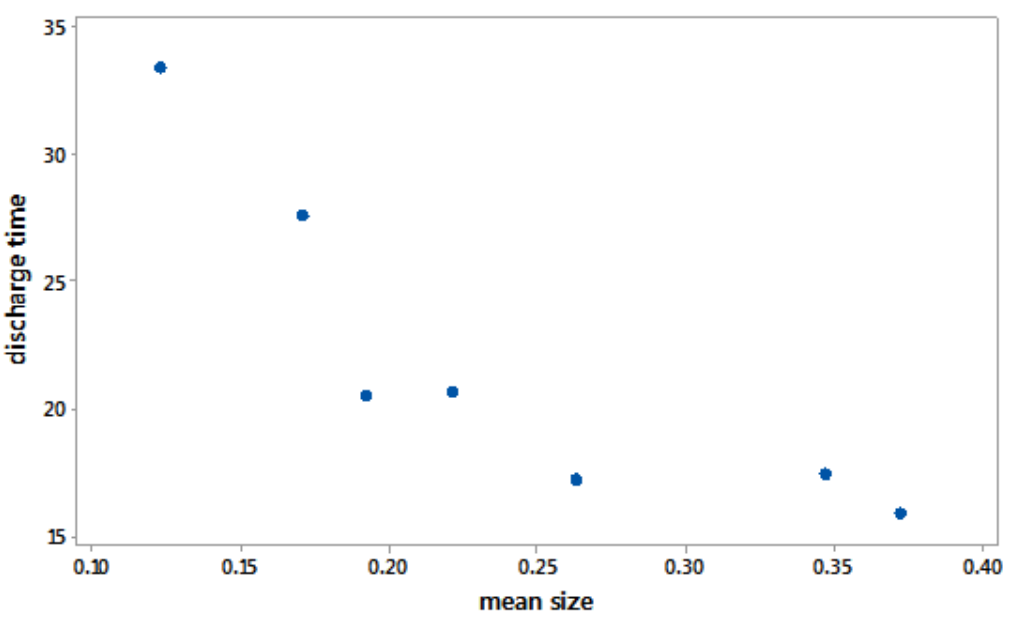
Fig. 5. Effect of granule mean size on